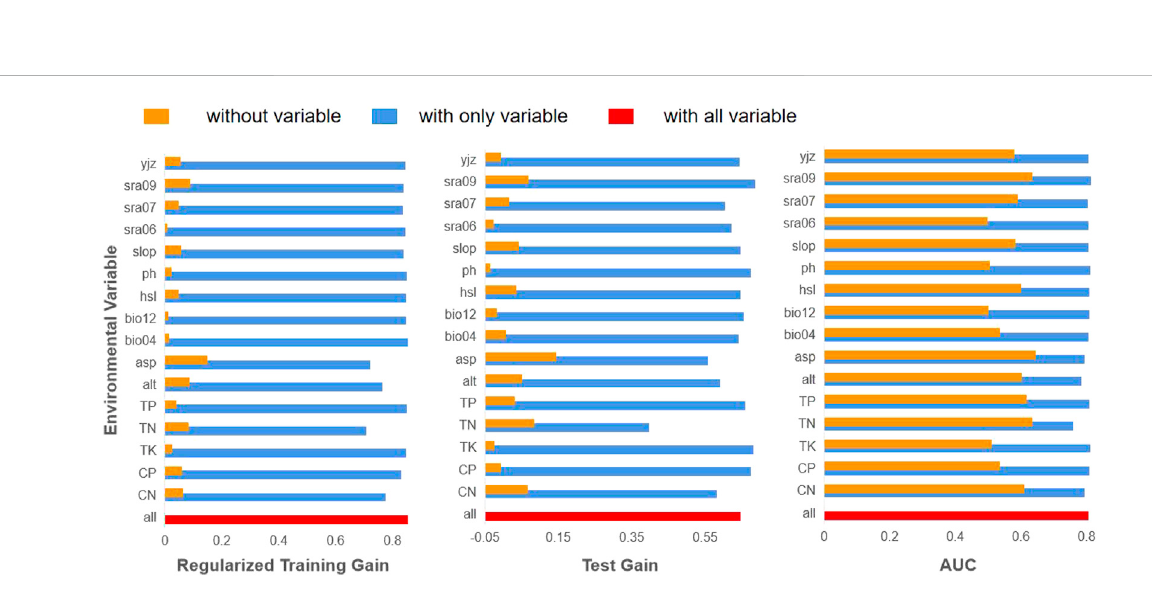
FIGURE 8 Contribution rate diagram of environmental factors based on